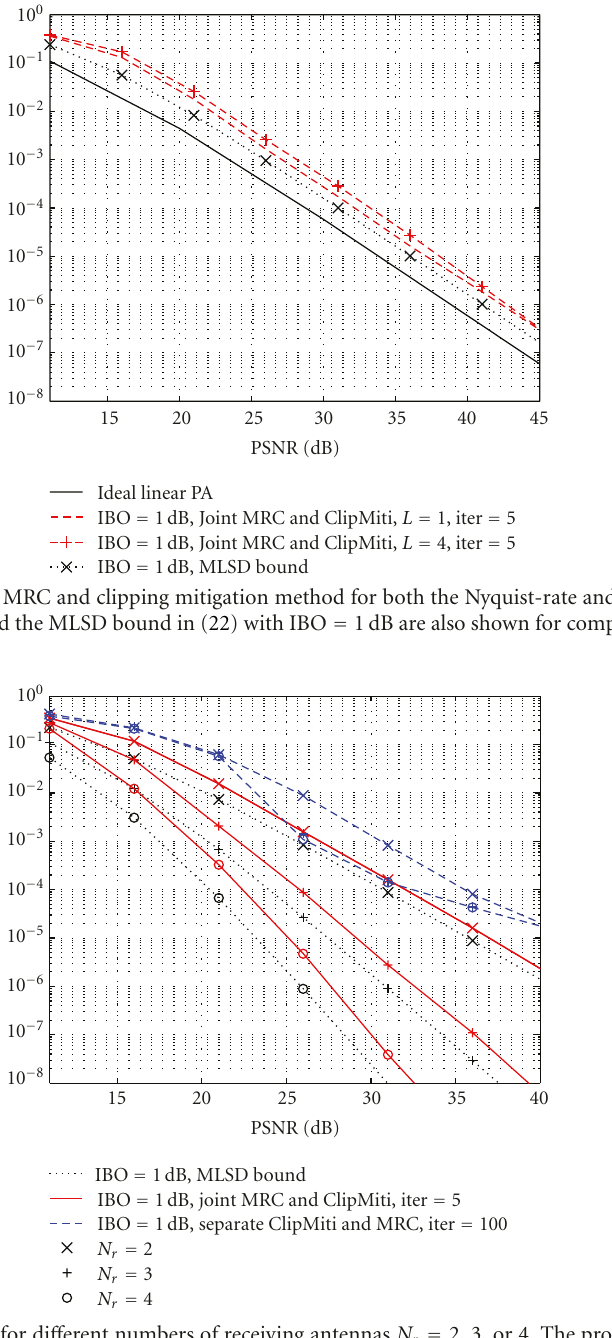
Figure 5: The SER versus PSNR curves for di ff erent numbers of receiving antennas N r = 2, 3, or 4. The proposed joint MRC and clipping mitigation method achieves a near-MLSD SER within five iterations. But separately using clipping mitigation [29] and MRC cannot collect full antenna diversity even after 100 iterations. IBO =